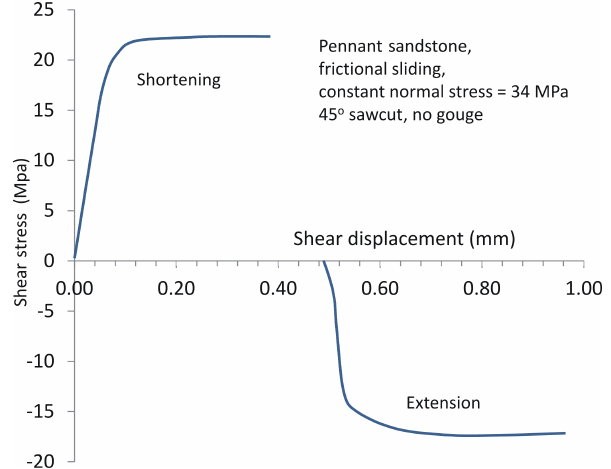
Figure 8. Shear stress versus shear displacement curves for Pennant sandstone sample Pa1a1 saw cut at 45 ◦ , sheared at constant normal stress first in shortening and then in